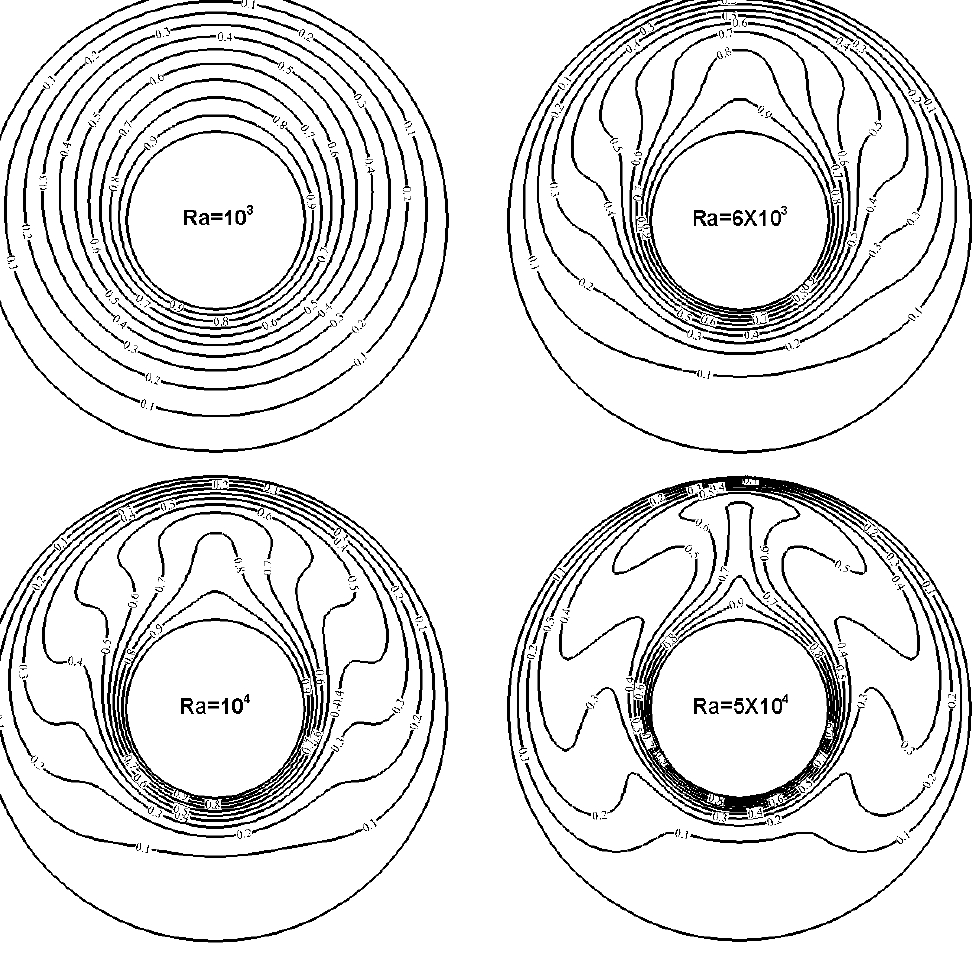
Figure 7. Isotherms for natural convection in a concentric annulus.